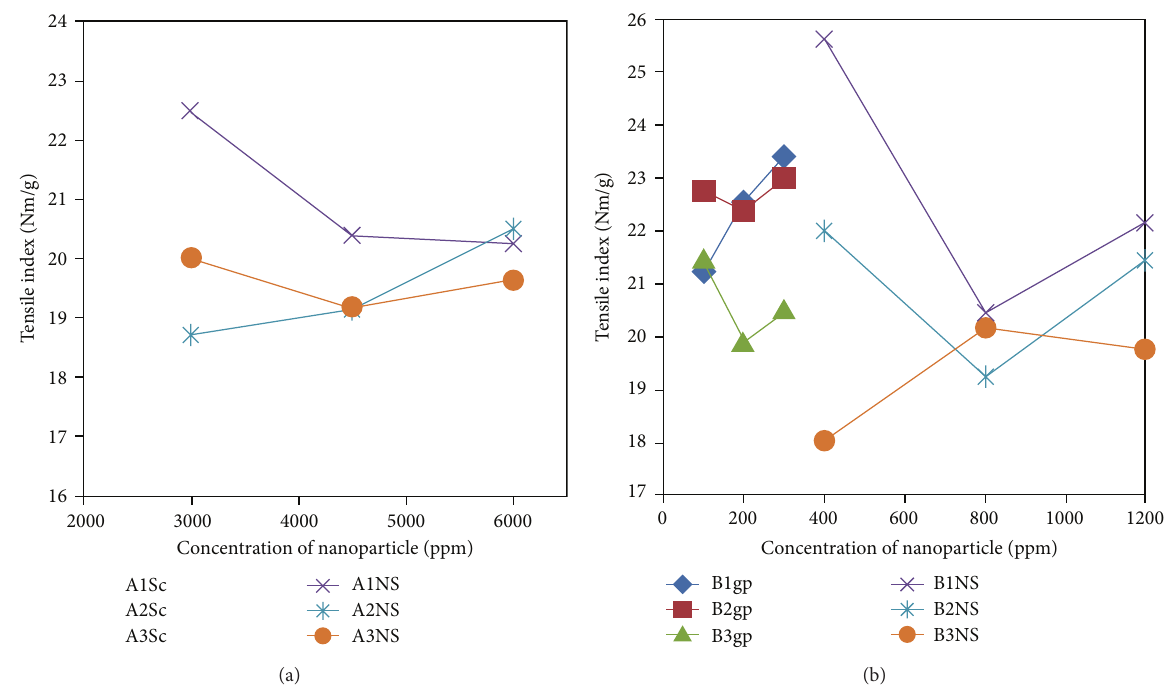
Figure 4: Effects of NS substituting for (a) Sc or (b) gp on the tensile strength of the resulting handsheets.